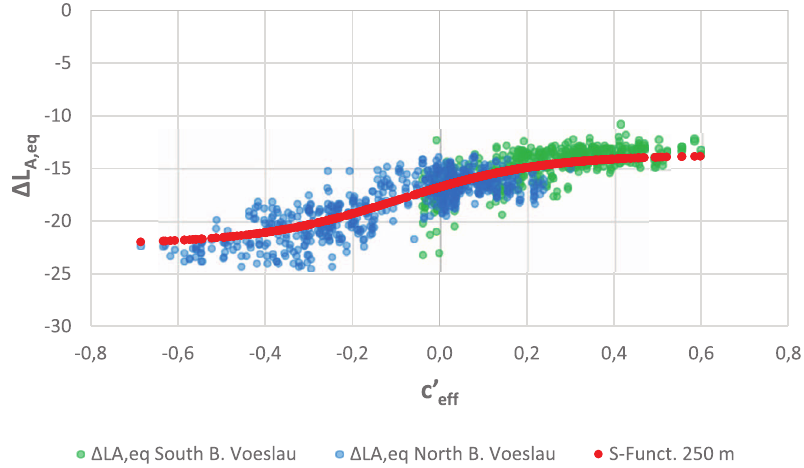
Figure 12. Bad Voeslau: Sound level difference D L A ,eq dependent on effective sound speed gradient ( c 0